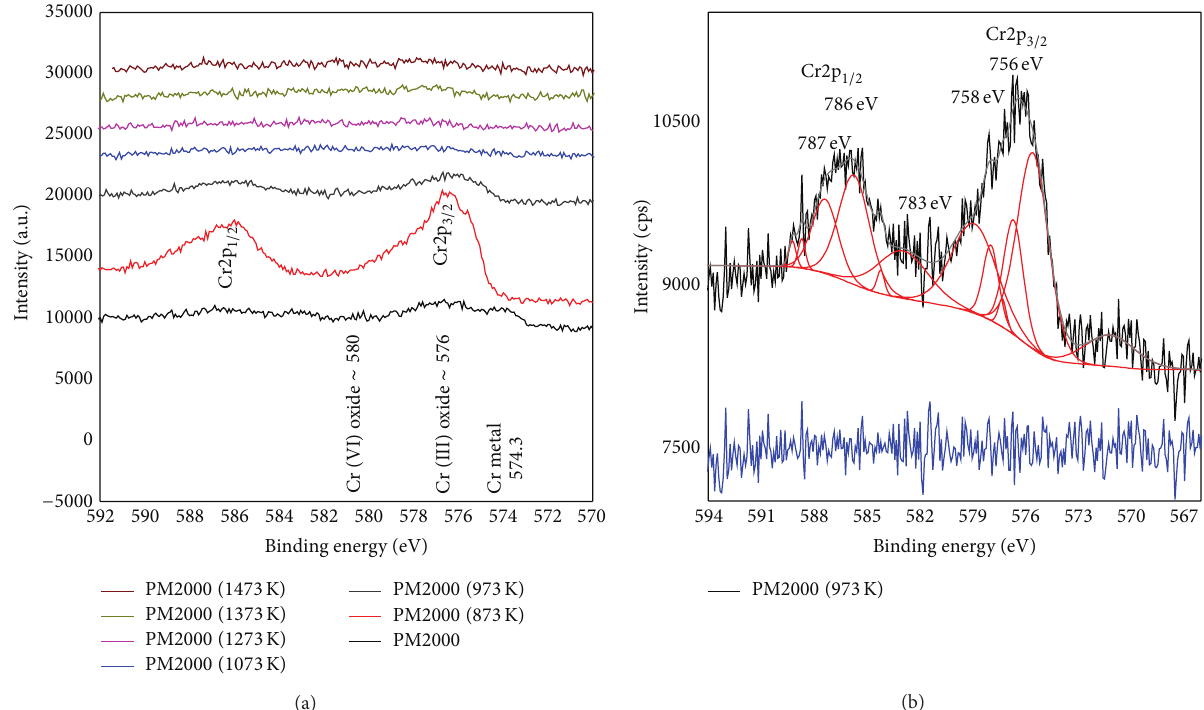
Figure 12: XPS spectra in the Cr2p region for as-received and treated PM2000 at various temperatures (a) and decomposed Cr2p peaks of oxidized PM2000 at 973 K (b).